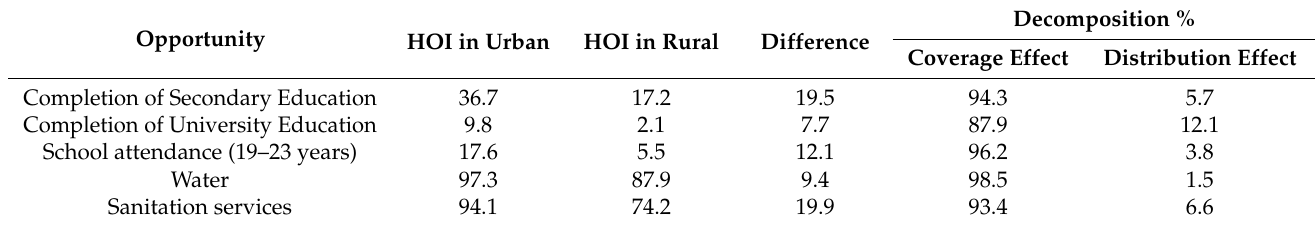
Table 6. Decomposition Human Opportunity Index for Moroccan youth aged 18–29